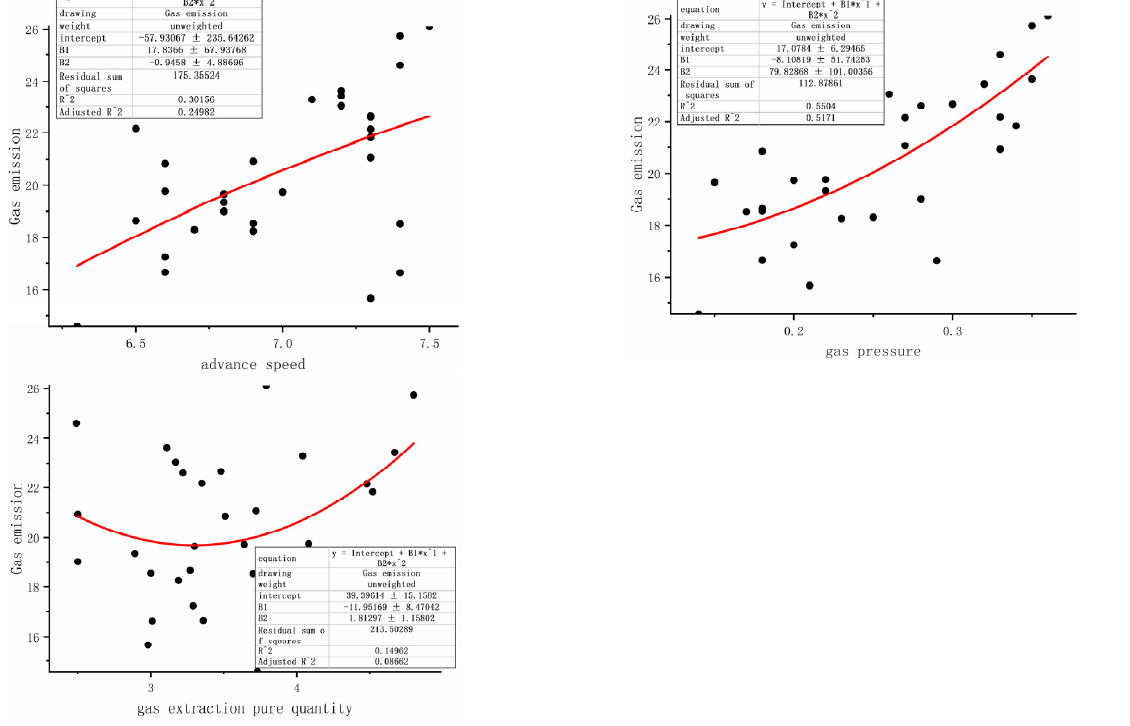
Figure 1. Linear fi tt ing diagram of gas emission and each quantitative index. Figure 1. Linear fitting diagram of gas emission and each quantitative index. Table 1. Mine gas emission and influencing